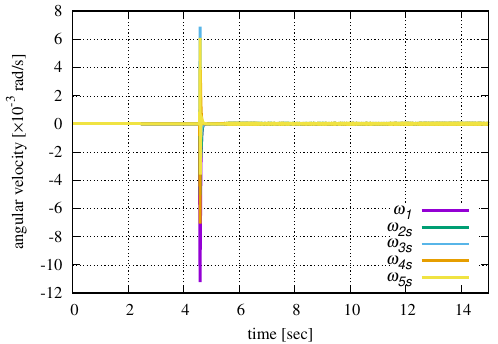
Figure 24. Case 2: Time variation of estimation error of the angular velocities.